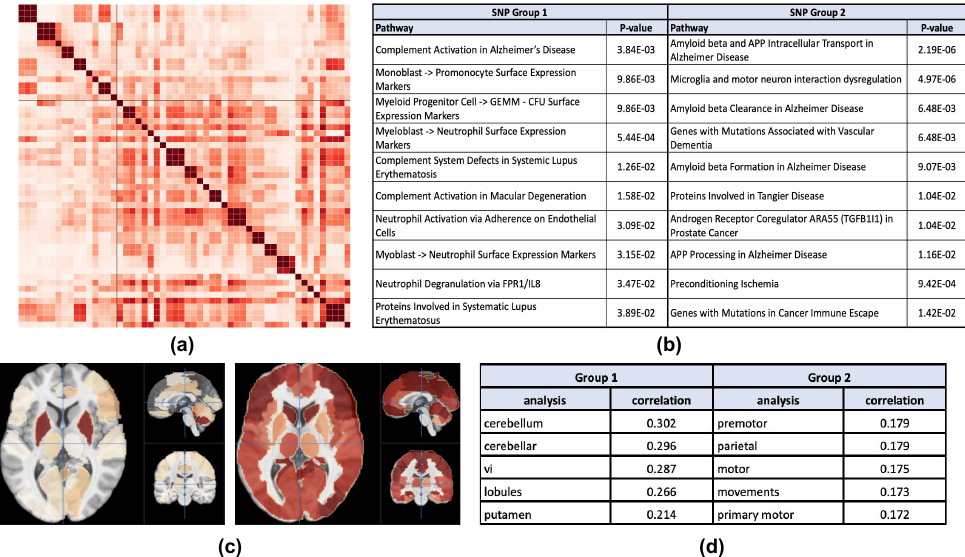
Figure 6. ( a ) Cosine SNP network derived from analyzing VBM data in the AD vs. HC comparison. ( b ) The Elsevier pathway analysis from EnrichR of SNP group 1 (16 SNPs) and SNP group 2 (38 SNPs). ( c ) The average normalized brain significance maps corresponding to SNP group 1 (left) and SNP group 2 (right), respectively. ( d ) Neurosynth analysis results of the two brain maps shown in ( c